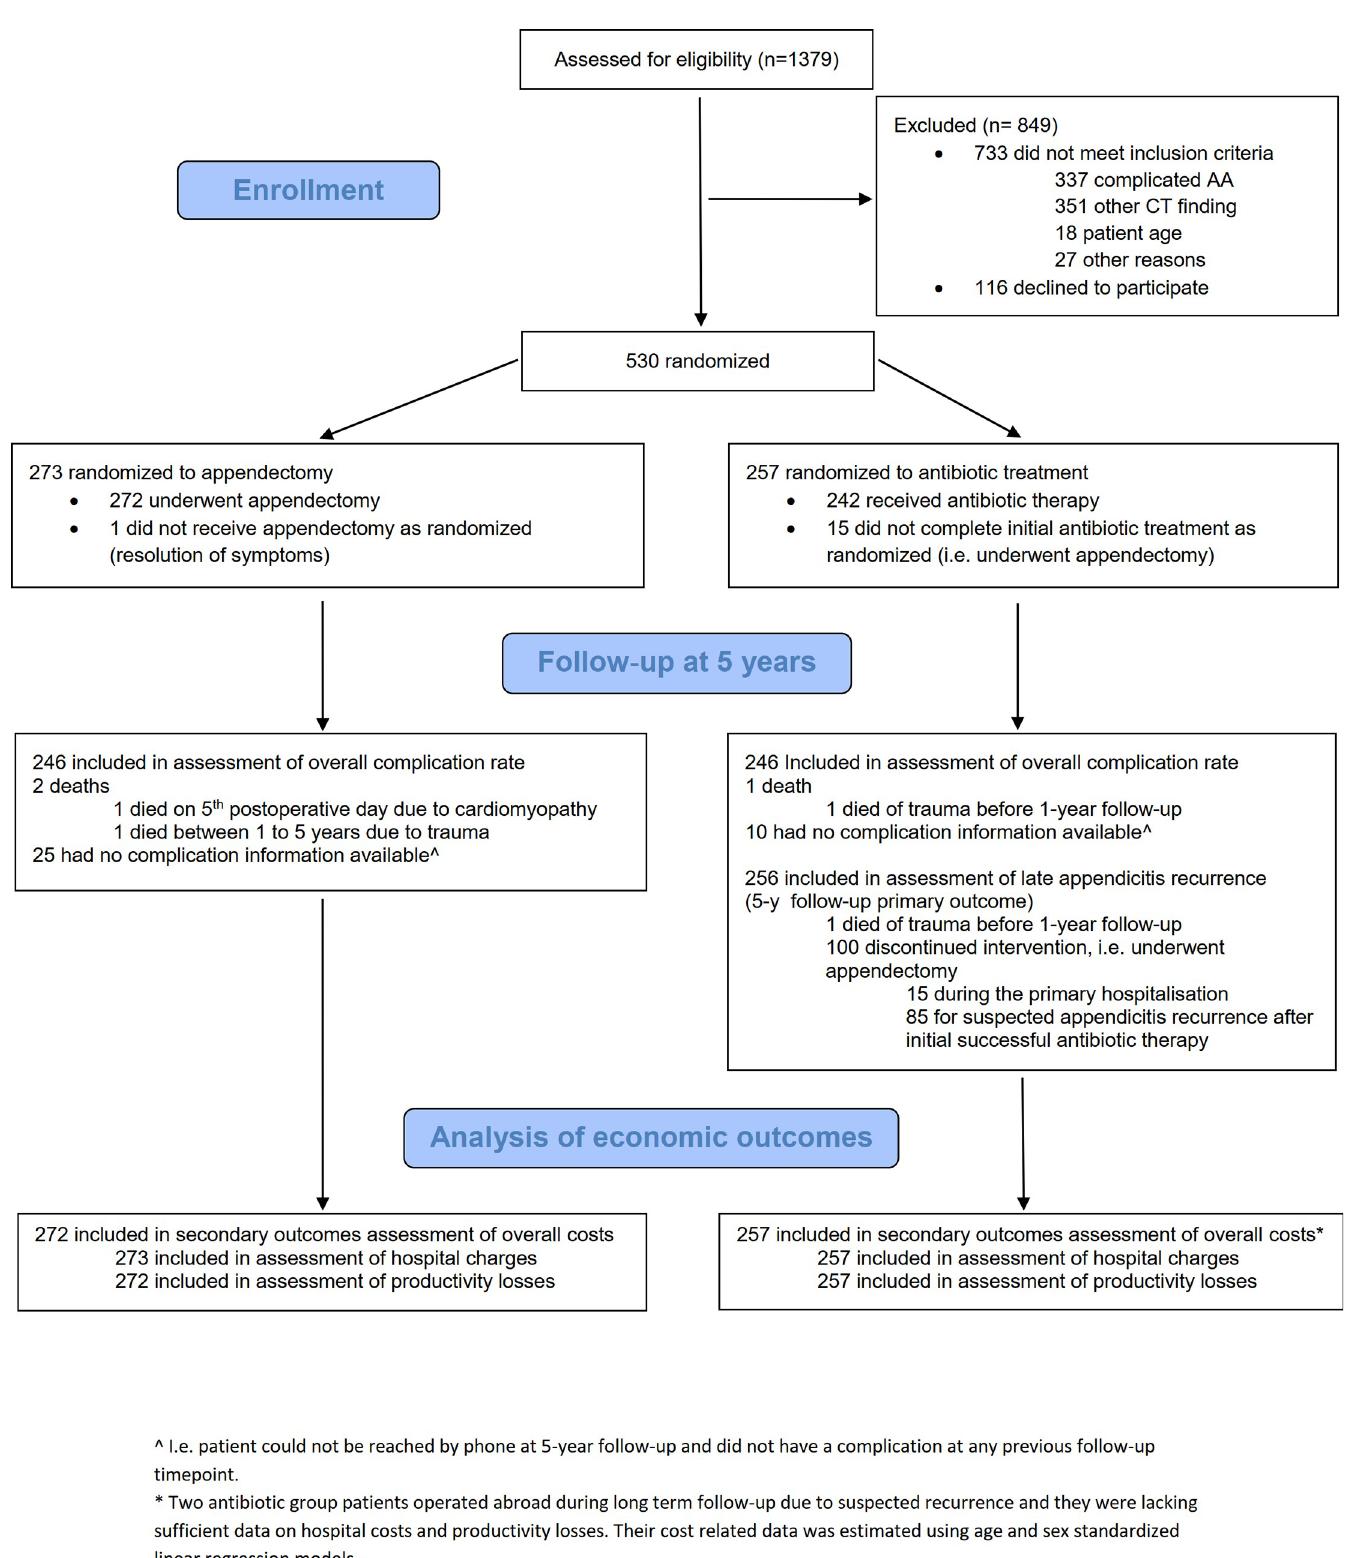
Fig 1. Path of patients in the APPendicitis ACuta (APPAC) trial.